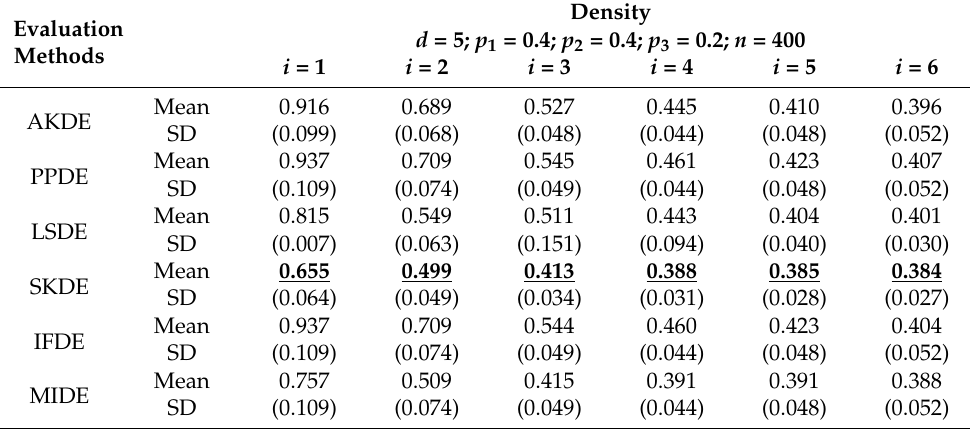
Table A4. 10 4 times upscaled mean absolute error with d = 5; p 1 = 0.4; p 2 = 0.4; p 3 = 0.2; n = 400.